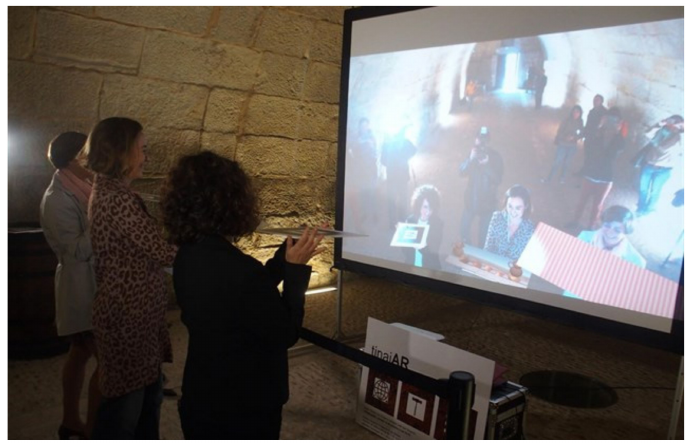
Figure 9. Artist Bibiana Mart í nez shows TinajAR to the mayor of Logroño,